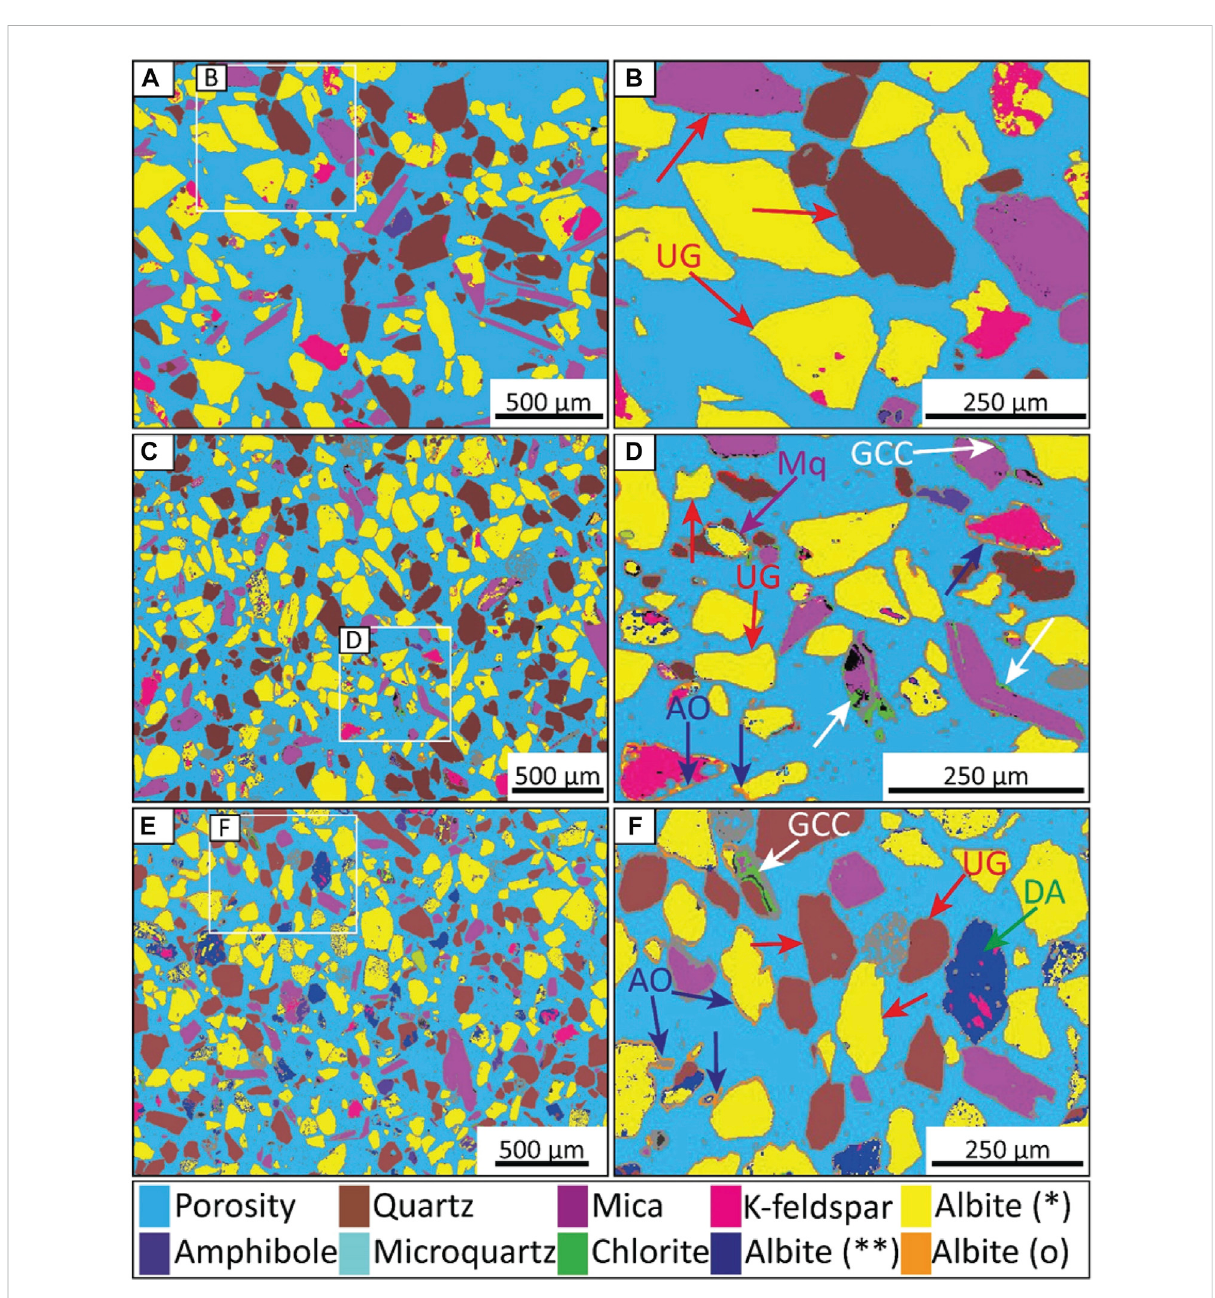
FIGURE 4 EDS mineral maps of the reacted and unreacted samples of Station 028A. (A) Processed EDS mineralogical map of the unreacted, pre- experiment Sample 1 showing the distribution of framework minerals. (B) Zoomed-in EDS mineral map of the inset in (A) . Note the uncoated grains (UG; red arrows) and the absence of grain-coating and pore- fi lling clays. (C) Analysed EDS mineral map of the post-experiment Sample 2. In this sample, chlorite coatings appear to be generally absent on the detrital grains. (D) Zoomed-in EDS mineral map of the inset in (C) . Notice the formation of albite overgrowths (AO) on K-feldspar grains, some coatings of microquartz (Mq) on grains, and the paucity of grain-coating chlorite (GCC) on detrital grains. (E) EDS mineral map of the post-experiment Sample 3. Grain-coating chlorite (GCC) appear to be generally absent on detrital grains. (F) Zoomed-in EDS mineralmap oftheinset in (E) . Notethedevelopment ofdiagenetic albite (DA)on partially to pervasively dissolved detrital plagioclase (albite) and K-feldspar grains. (*, Detrital albite; **, Diagenetic albite; o, Albite